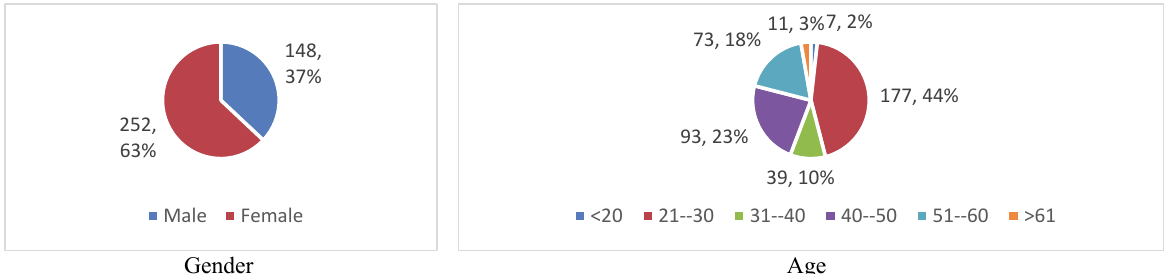
Fig. 1. Distribution of Respondents’ Particulars a , N =